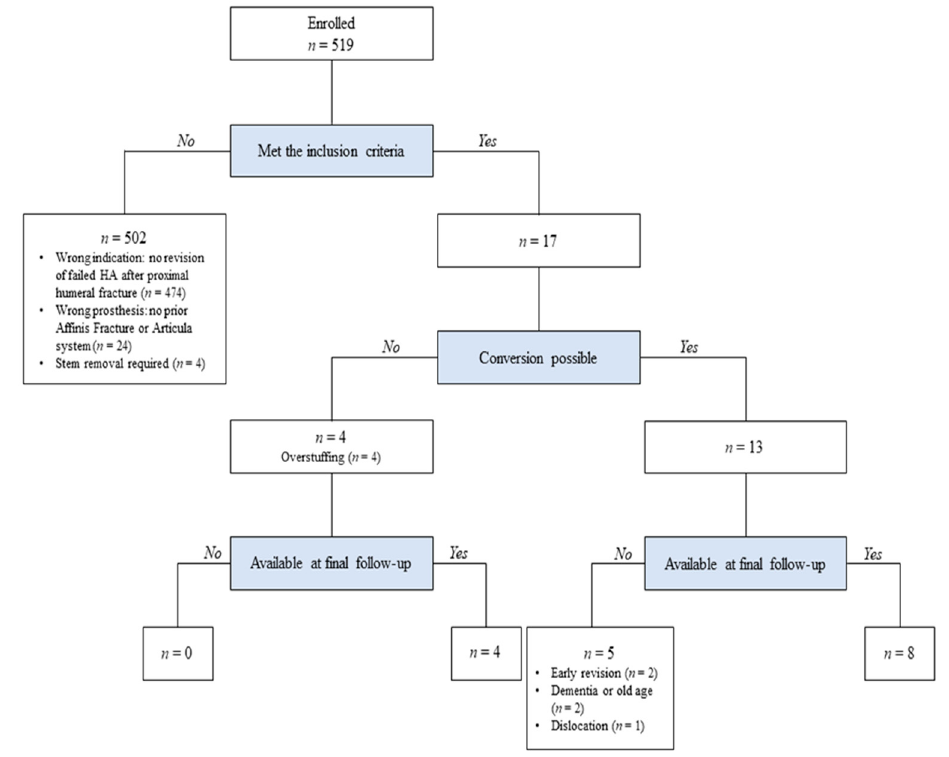
Figure 1. Flow diagram of the patient selection.